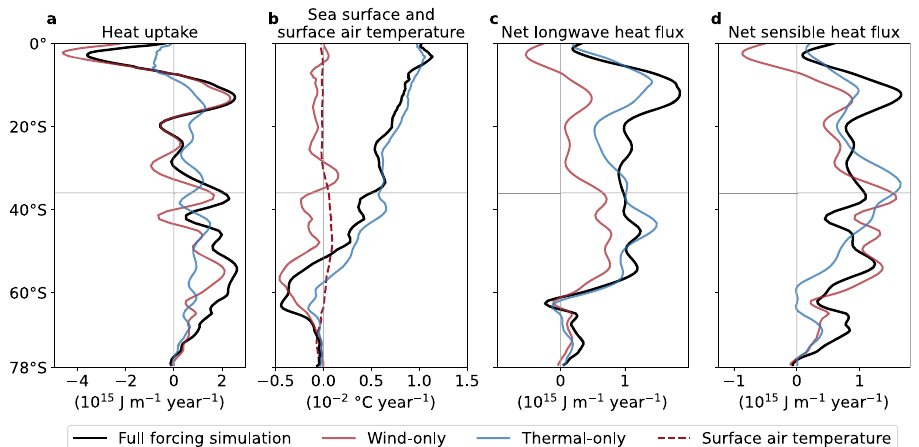
Fig. 5 | Southern Hemisphere ocean heat uptake, sea surface temperature and surface air temperature, net longwave and net sensible heat fl ux trends over 1972 – 2017.a Zonallyintegrated heat uptake inthe simulationswith full, wind-only and thermal-only forcing (10 15 J year − 1 ), equal to the zonal integral of the spatial structure shown in Fig. 2a and Supplementary Fig. 5a, e. b Zonal mean sea surface